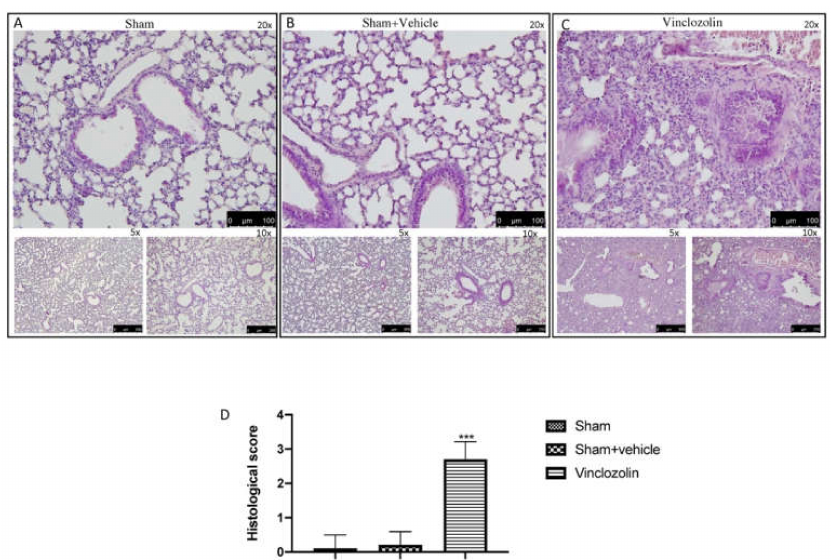
Figure 1. Vinclozolin-induced histological alterations. Square ( A ): images of sham animals at different magnifications (5 × , 10 × , and 20 × ); Square ( B ): images of sham + vehicle animals treated for 28 days with corn oil at different magnifications (5 × , 10 × , and 20 × ); Square ( C ): images of vinclozolin-treated animals at different magnifications (5 × , 10 × , and 20 × ); ( D ): Histological score. After vinclozolin administration, we observed a moderate thickening of the walls without obvious damage to the lung architecture. Values are the means ± SD of 6 mice per group. Images shown are representative of the results obtained. See manuscript for further details. *** p < 0.001 vs. sham.